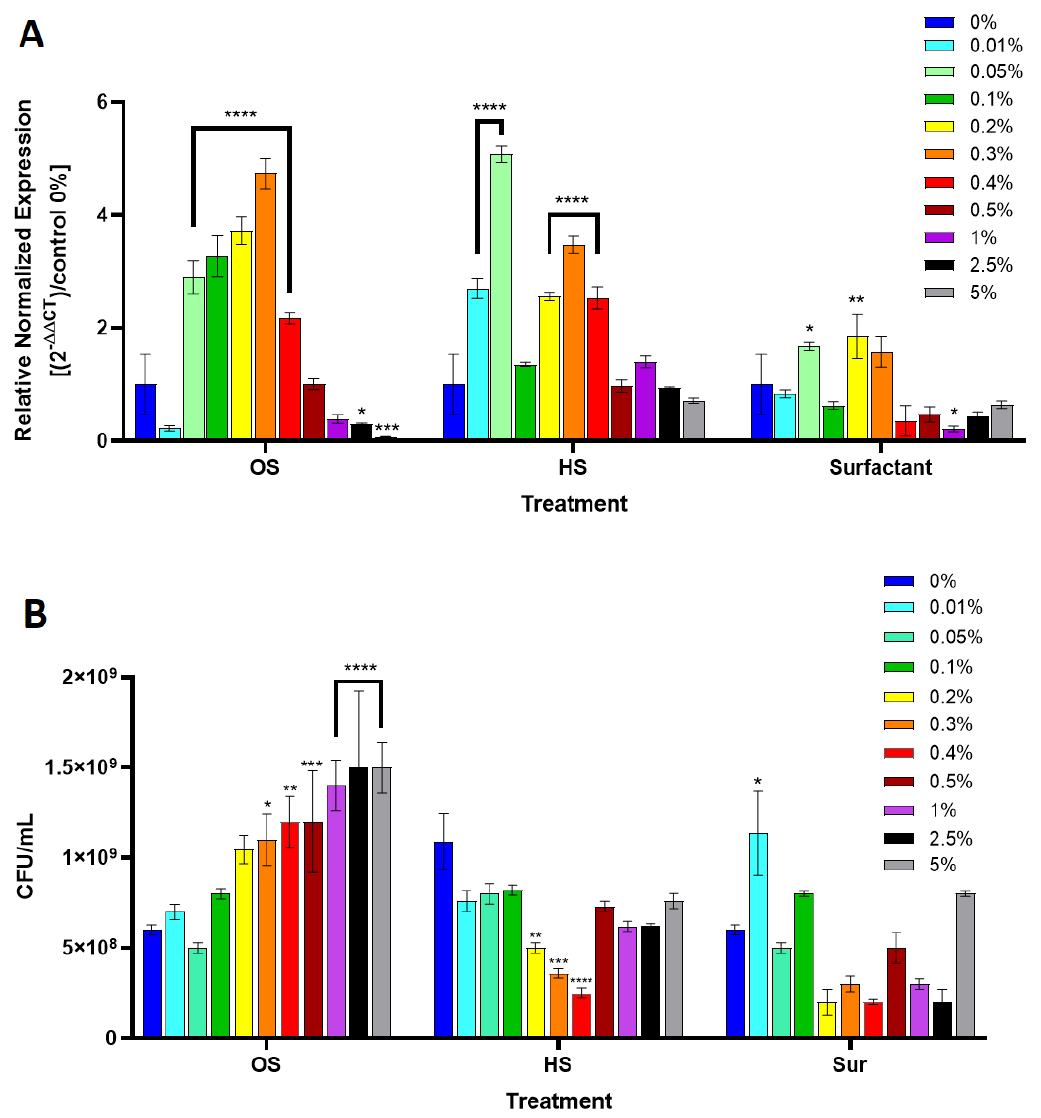
Figure 4. Pseudomonas aeruginosa pchD gene expression during treatment with subinhibitory concentrations of octyl salicylate (OS) and homosalate (HS). ( A ) Increasing concentrations of OS and HS were added to a P. aeruginosa culture and incubated ON. pchD gene expression was assessed against the rpoS housekeeping gene. The surfactant used to dissolve the compounds into the growth medium act as an additional control. Data are presented as 2 −ΔΔCT normalized expression levels to the 0% negative control treatment, ± SD. ( B ) Viability of P. aeruginosa was documented for each treatment while data are presented as mean CFU/mL ± SD. Significant differences in comparison to the control treatment (0%), are indicated in the graph ( p -value *<0.05, **<0.01, ***<0.001, ****<0.0001).